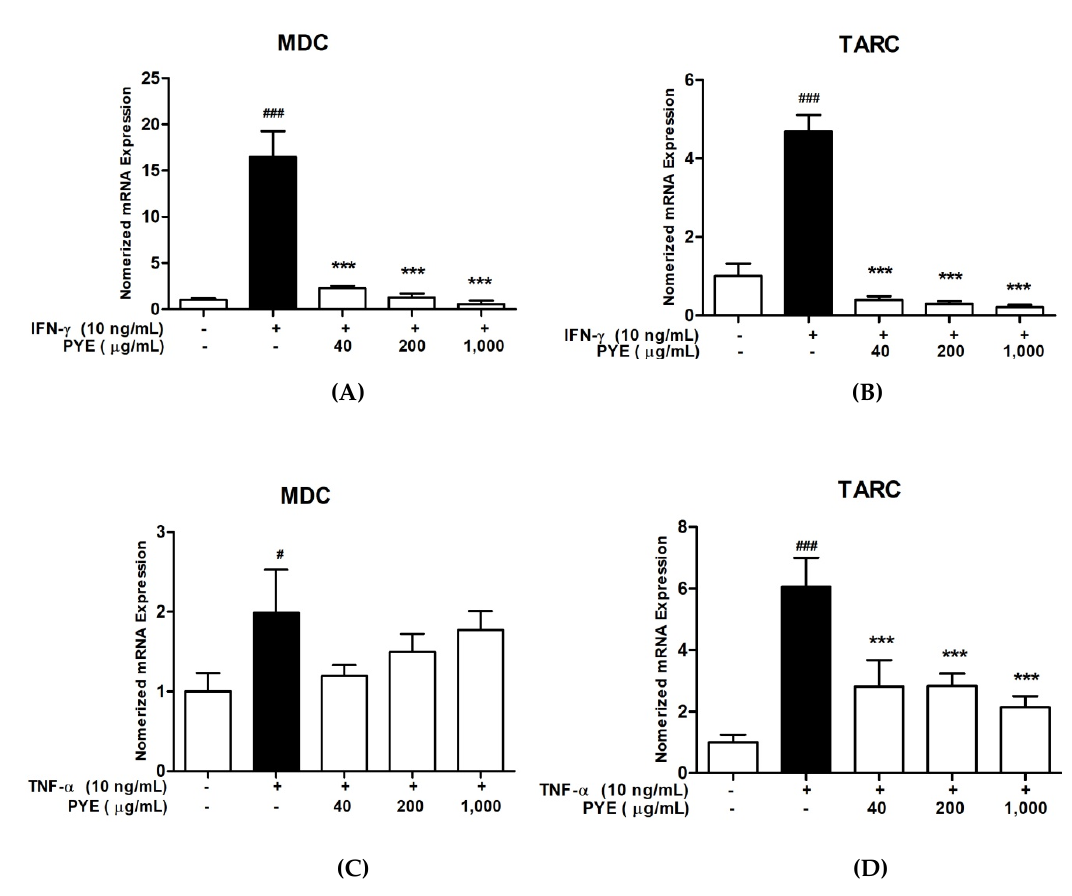
Figure 2. Effects of PYE on mRNA expression of macrophage-derived chemokine (MDC) and thymus, and activation-regulated chemokine (TARC) in HaCaT cells stimulated with IFN-γ ( A, B ) or TNF-α (C, D ). HaCaT cells were co-treated with PYE and IFN-γ or TNF-α (10 ng/mL) for 24 h. After treatment, the mRNA expression of MDC and TARC was measured and normalized to glyceraldehyde 3-phosphate dehydrogenase (GAPDH) expression. Values are means ± standard error of mean (SEM) of three independent experiments. Statistical comparisons of different treatments were performed using one-way analysis of variance (ANOVA) with Tukey’s multiple comparison test. Note: ### p < 0.001 and # p < 0.01 control group vs. the IFN-γ or TNF-α (10 ng/mL)-treated group, and *** p < 0.001 IFN-γ or TNF-α (10 ng/mL)-treated group vs. PYE co-treated group.